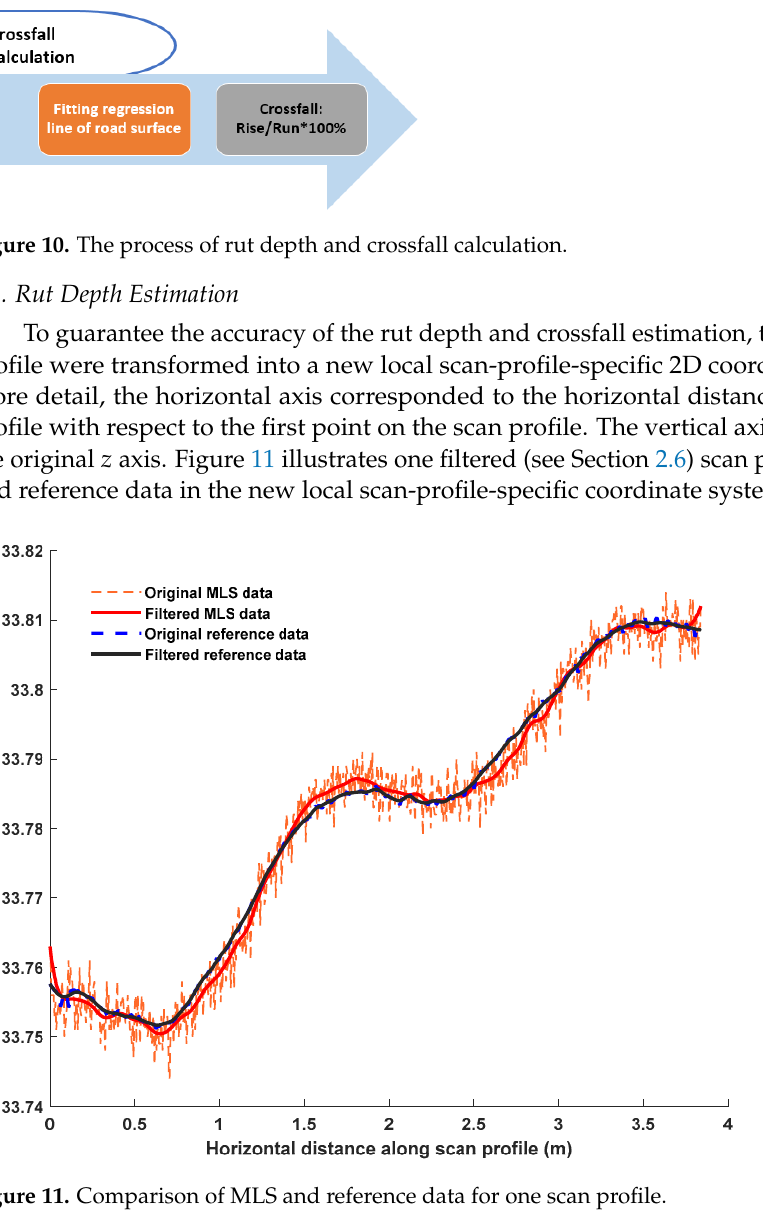
Figure 11. Comparison of MLS and reference data for one scan profile.